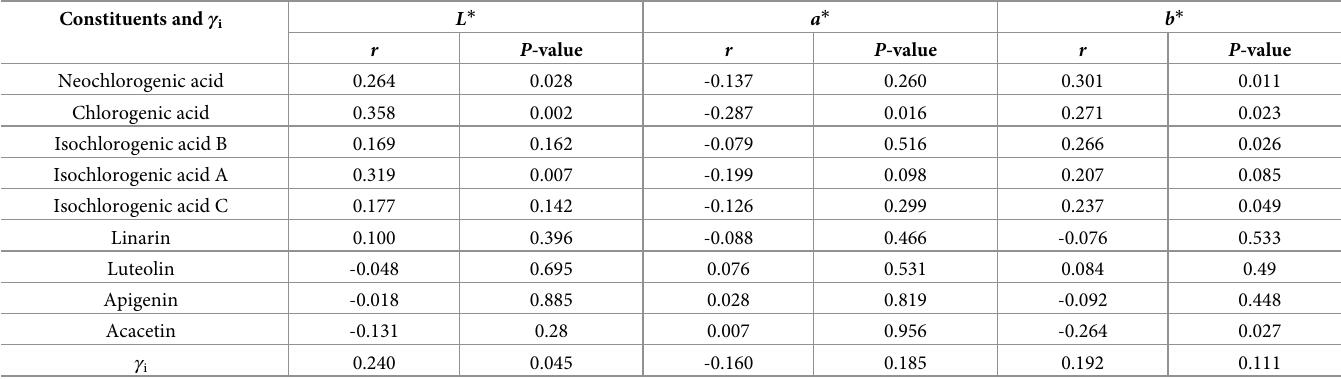
Table 5. Correlation analysis of CIF constituents, γ i and color parameters.